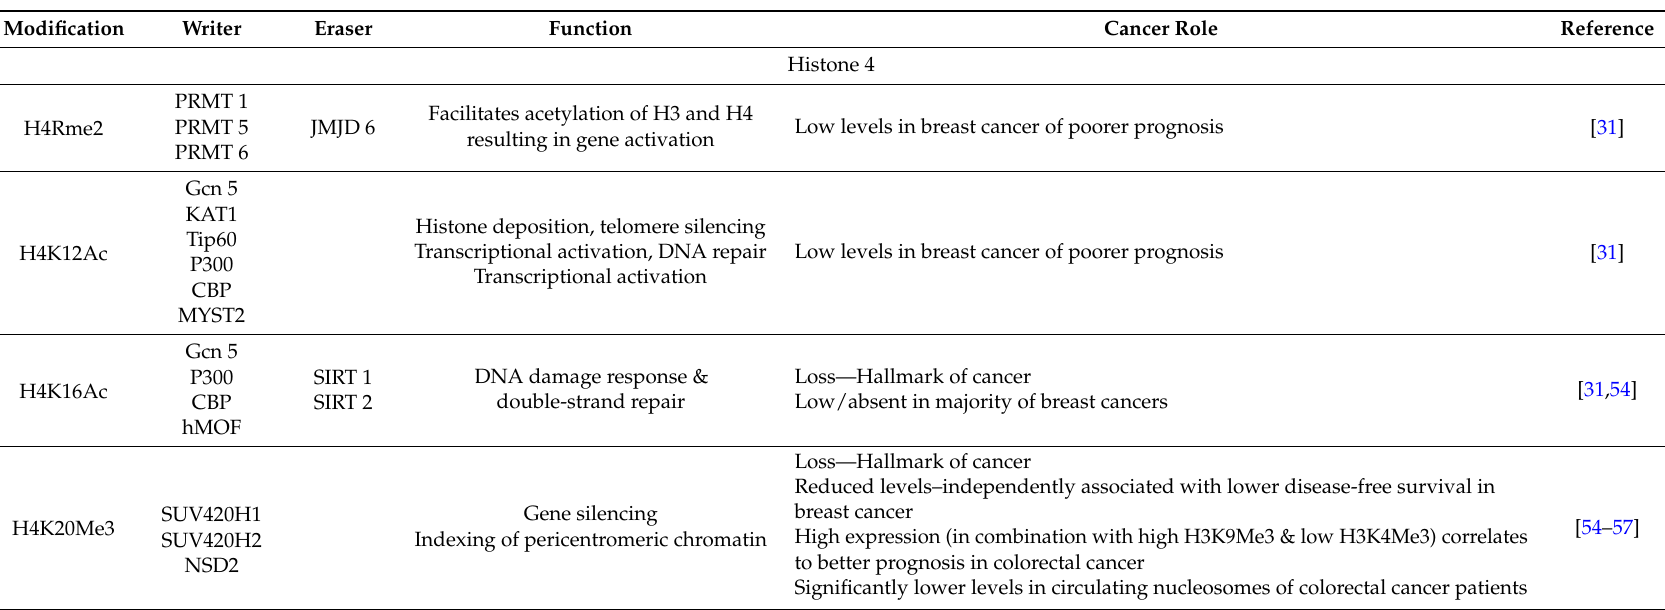
Table 3. Histone 4: PTM quantification as cancer